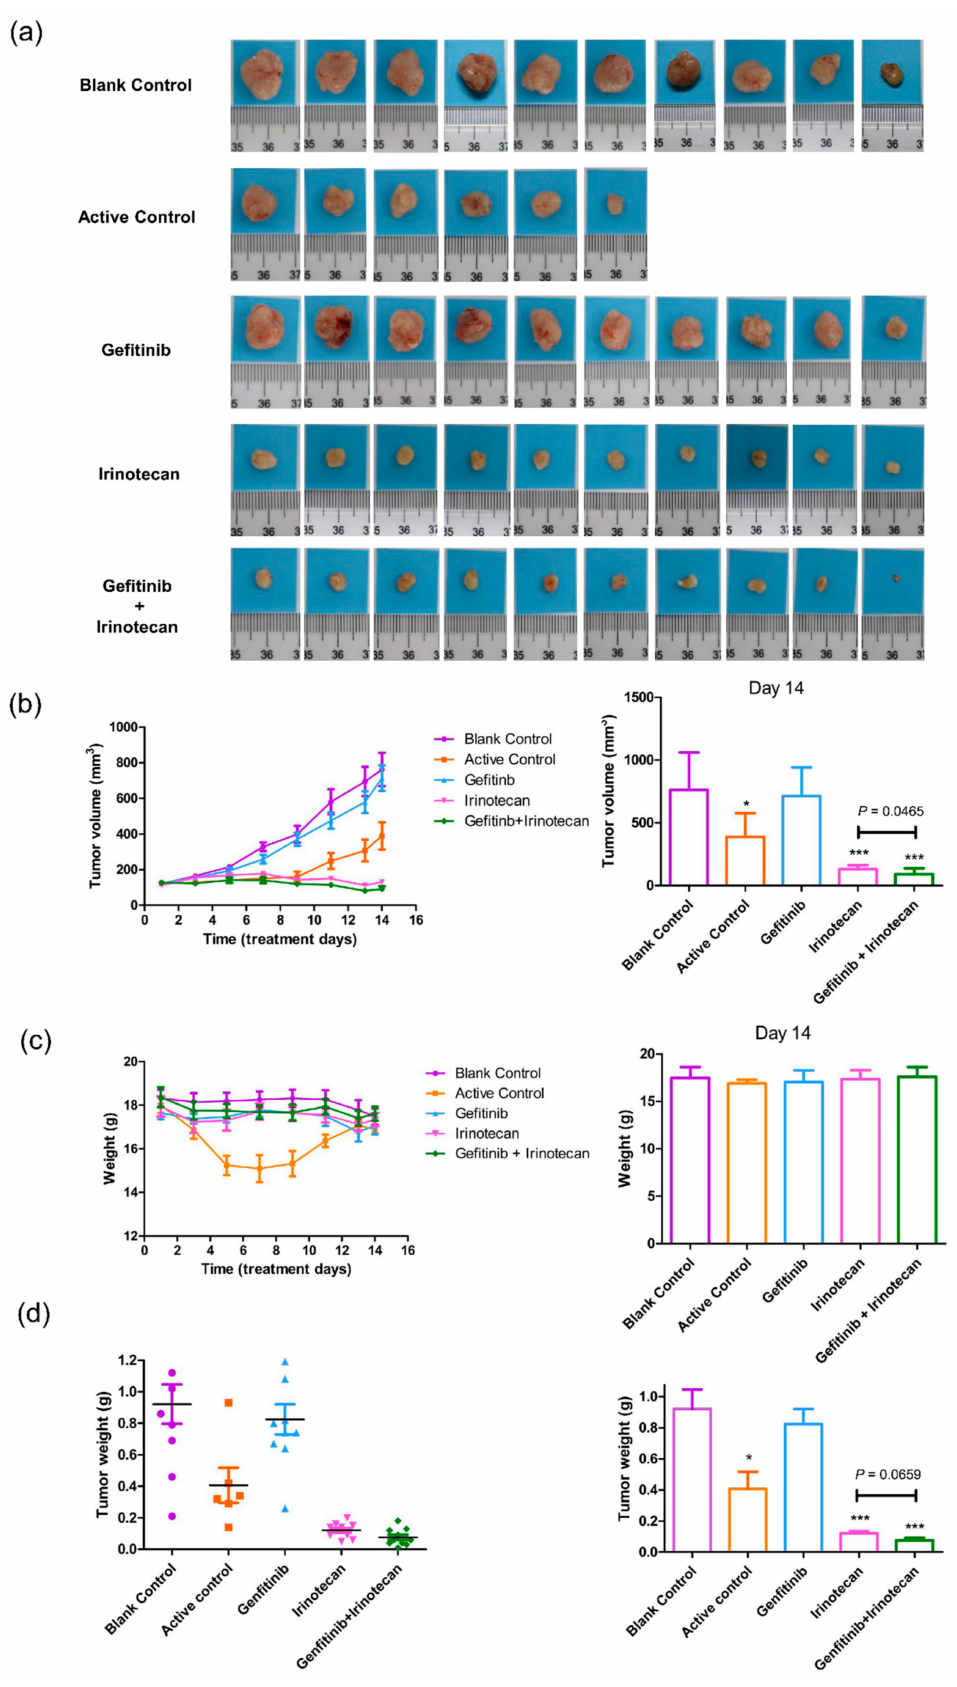
Figure 6. Effects of gefitinib and irinotecan on cell-derived xenograft models constructed with MDA-MB-231 cell lines. ( a ) After 14 days of drug treatment, the tumours of the nude mice were removed and photographed on a 2 cm × 2 cm